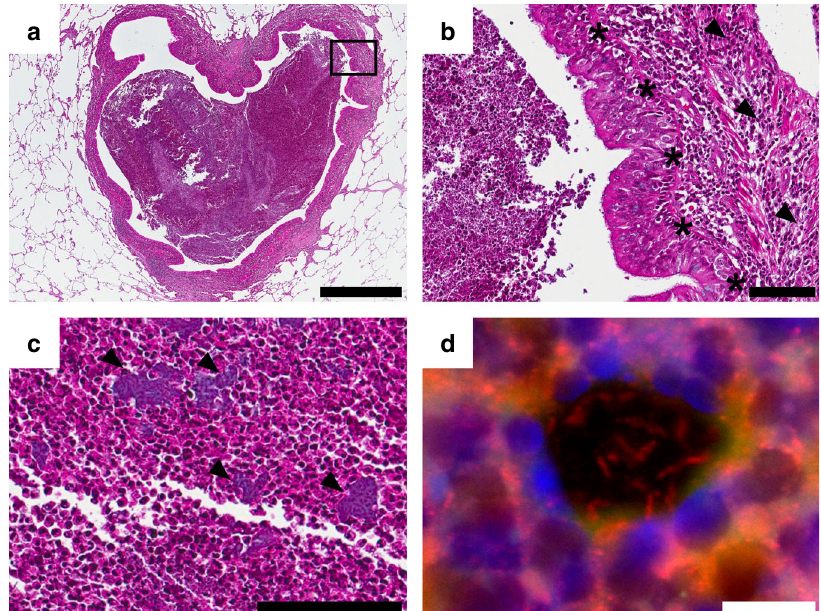
Fig. 2 Histological analysis of the cystic fi brosis (CF) lung. The hematoxylin – eosin-stained tissue sections ( a – c ) show lung parenchyma with a dilated conducting airway (bronchiectasis) fi lled with mucopurulent secretions ( b detail of a ). The airways retain their typical lining with ciliated columnar epithelium (asterisk). Reserve cell and goblet cell hyperplasia as well as scarring and chronic in fl ammation (arrowhead) of the bronchial wall can be observed. c Bacterial colonies (arrowhead) are found in the airway lumen mucopurulent secretions. d Residing bacteria are identi fi ed as P. aeruginosa by application of a species-speci fi c fl uorescence in situ hybridization. Scale bars of 1000 µ m ( a ), 100 µ m ( b , c ), and 10 µ m ( d ) are